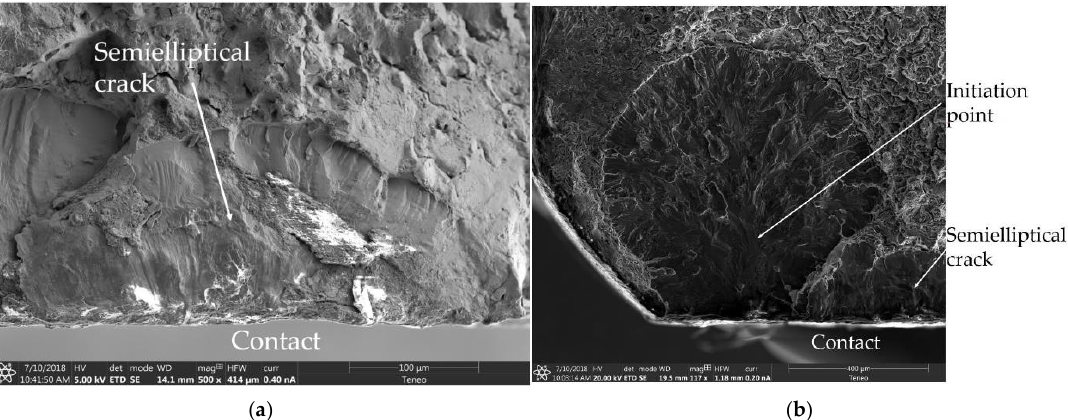
Figure 13. Fracture surface of specimens with shot peening: ( a ) Load Combination 22; ( b ) Load Combination 19.